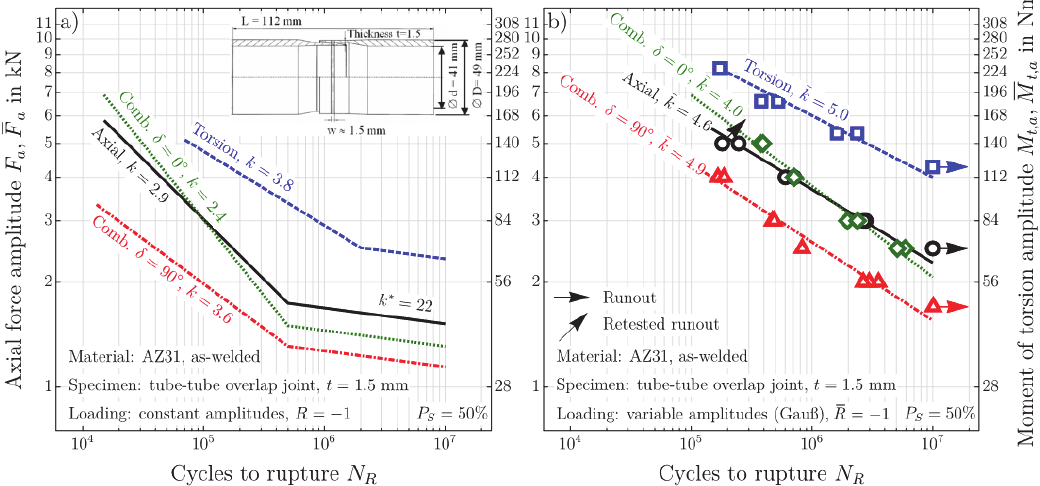
Figure 1: Wöhler (a) and Gaßner (b)-lines for the welded joints made of AZ31 alloy. The specimen geometry is shown as well .